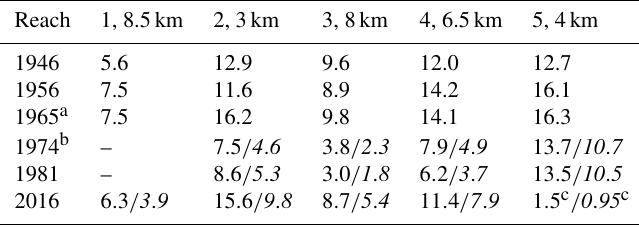
Table 5. Carrying capacity ( × 10 3 m 3 /yr) of the five reaches and all years. The values in italics are the capacity with reservoirs. Reach 1, 8.5km 2, 3km 3, 8km 4, 6.5km